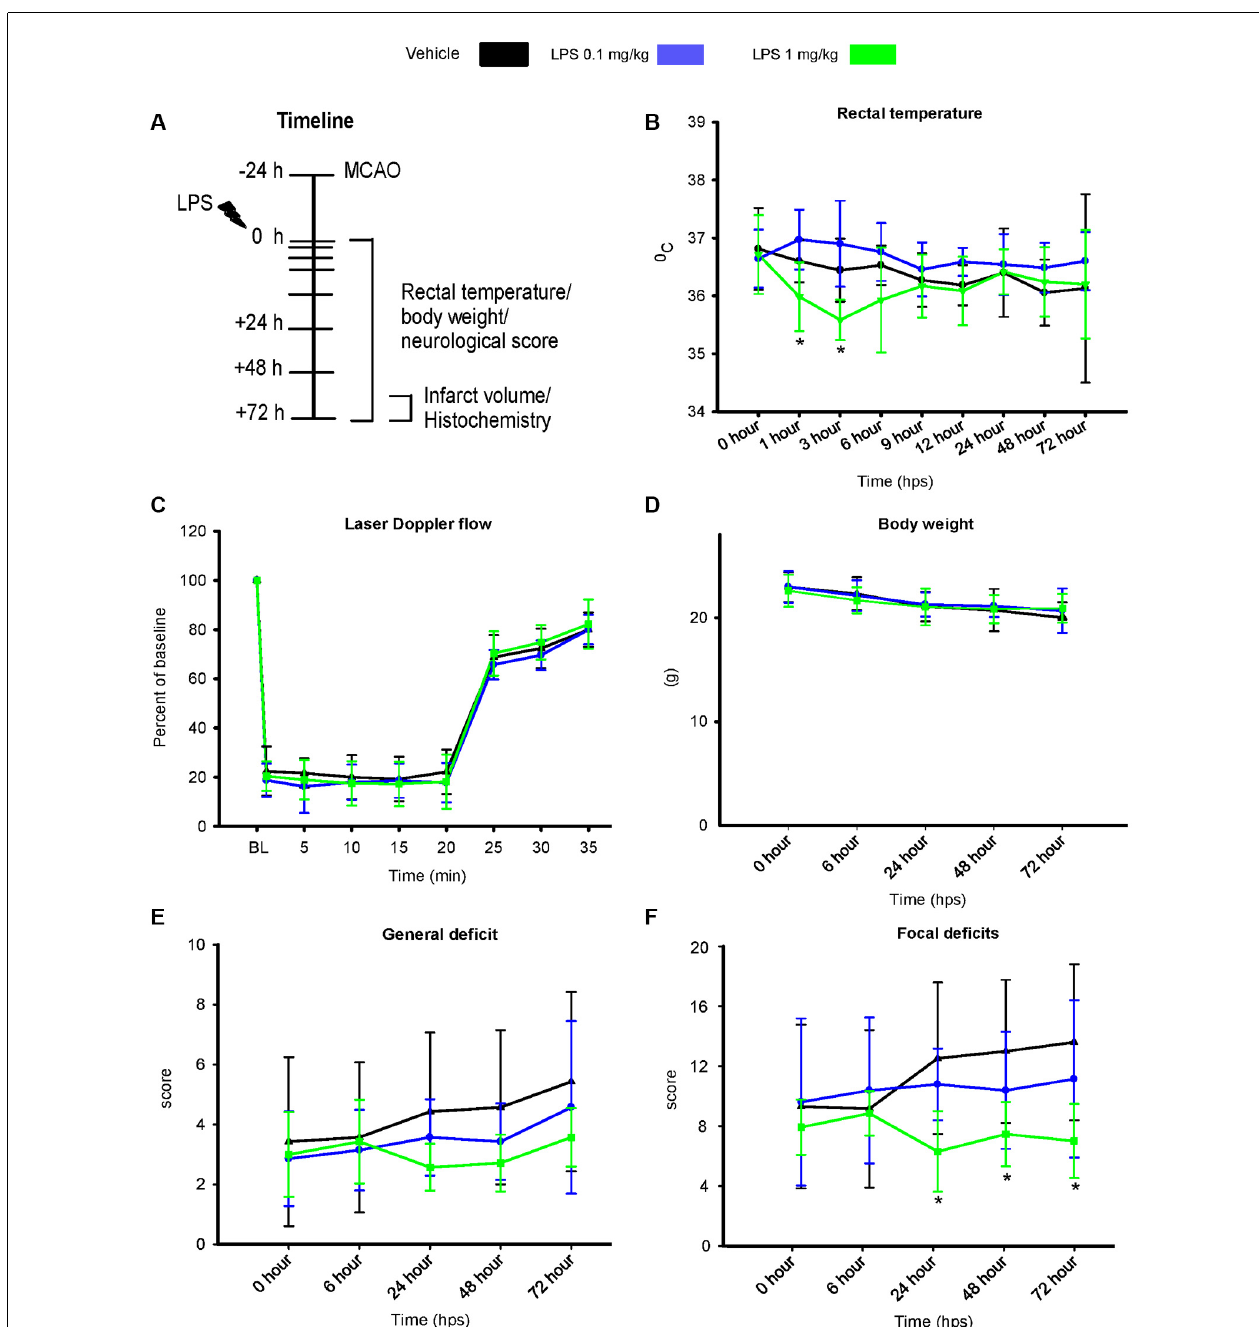
FIGURE 1 | Post-ischemic lipopolysaccharide (LPS) delivery dose-dependently induces transient hypothermia and promotes neurological recovery. (A) Timeline of the experimental procedure, (B) rectal temperature, (C) laser doppler flow (LDF) recordings above the middle cerebral artery territory, (D) body weight as well as (E,F) general and focal neurological deficits assessed by Clark score in mice exposed to transient intraluminal middle cerebral artery occlusion (MCAO). Vehicle or LPS (0.1 or 1 mg/kg) was intraperitoneally administered at 24 h after MCAO. Note that the higher dose of LPS induces transient hypothermia at 1 and 3 hours post-sepsis (hps) and a reduction of focal neurological deficits at 24–72 hps. Results are means ± SD values. * p < 0.05 compared with vehicle group ( n = 7